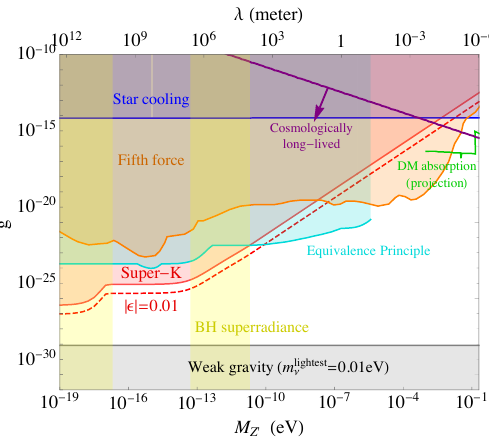
Figure 1 . Constraints on the parameter space of a lepton (cid:13)avorful long range force, which apply to gauge L e (cid:0) L (cid:22) model (similarly for the L e (cid:0) L (cid:28) model). The solid (dashed) curve corresponds to a neutrino matter potential (cid:15) (cid:22)(cid:22) = (cid:0) (cid:15) ee = (cid:0) 0 : 147 and (cid:0) 0 : 01, respectively. The red shaded region has been excluded by Super-K. The shaded orange (cyan) regions are excluded by (cid:12)fth force (equivalence principle) test experiments. The blue shaded region is excluded due to too much stellar cooling through the Z 0 into neutrinos. The gray shaded region is the lower limit on g 0 by requiring there is at least one particle charged under the new U(1) (assuming the lightest neutrino has mass 0.01 eV) for which gravity is the weakest force. The yellow shaded region is ruled out by superradiance using model dependent determinations of black hole spin. Below the purple line, the Z 0 is cosmologically long lived and could be the dark matter candidate, assuming the lightest neutrino is massless. If the lightest neutrino has a nonzero mass, the g 0 coupling could be higher. The green curve shows the sensitivity of proposed direct detection experiments using special